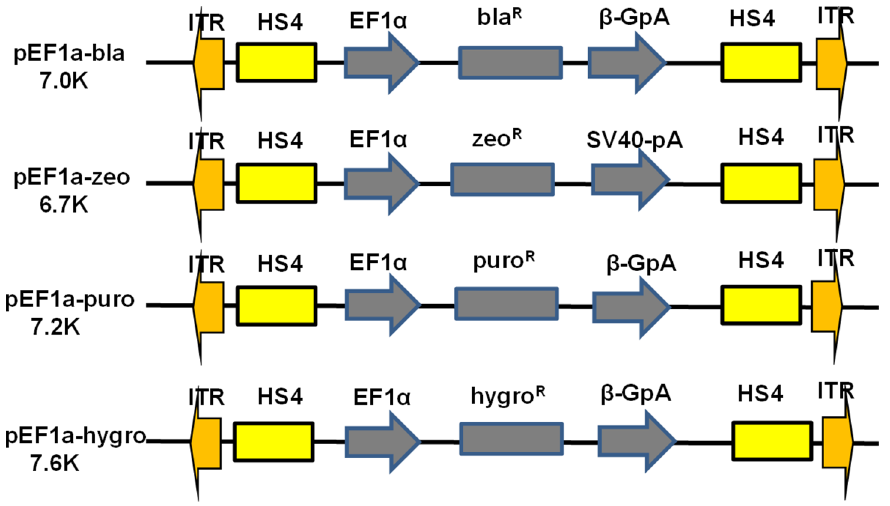
Fig. 1. Schematic representation of four antibiotic resistance gene expressing transposons based on PiggyBac backbone. Bla R , blasticidin-resistance gene; zeo R , zeocin-resistance gene; puro R , puromycin resistance gene; hygro R , hygromycin resistance gene; EF1 a , human elongation factor 1 a promoter; ITR, terminal repeats; HS4, chicken b -globin hypersensitive site 4 insulator.